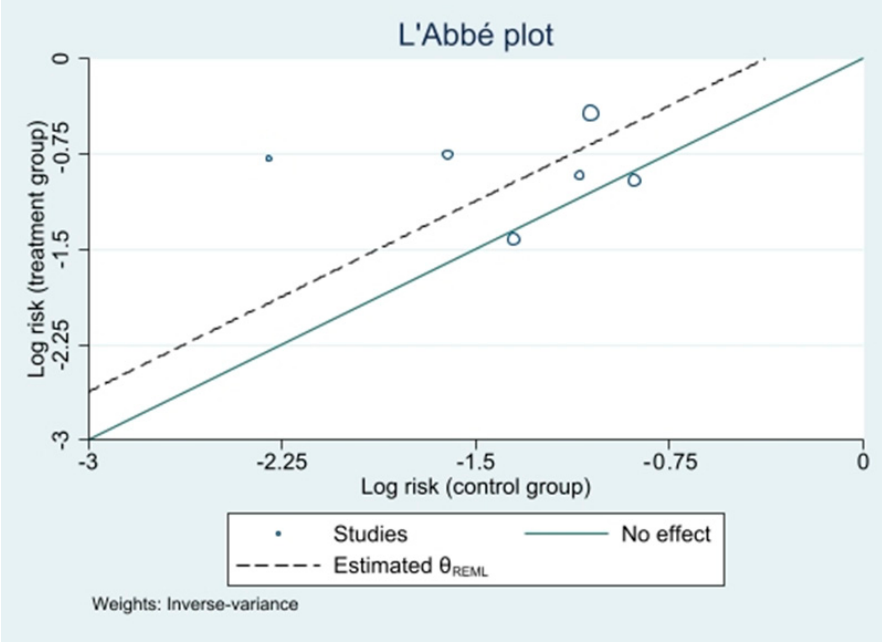
Figure 7. L’Abbé plot. Figure 7. L’Abb é